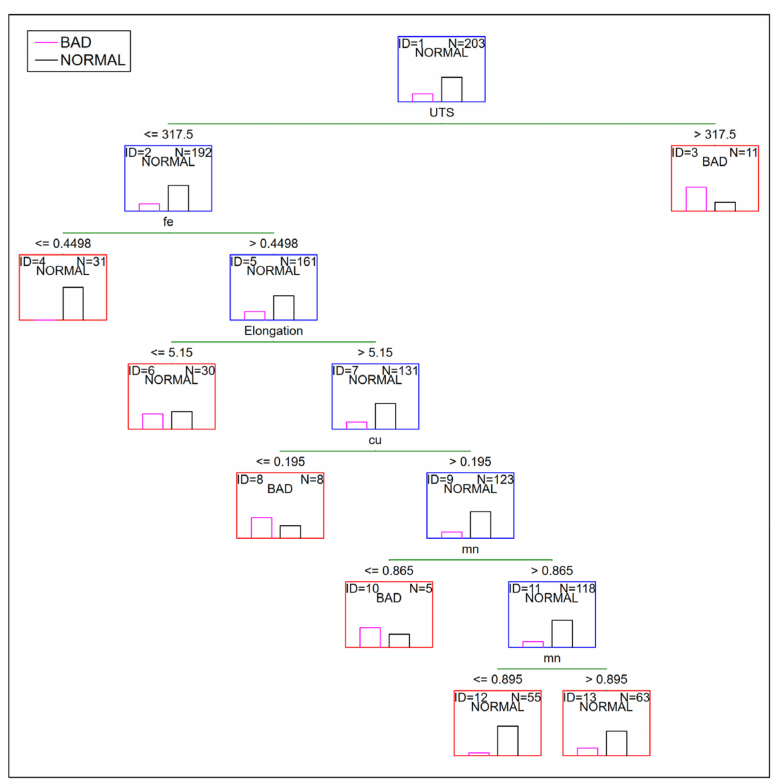
Figure 12. Interactive classification tree for the amount of short cans (3Q), C&RT